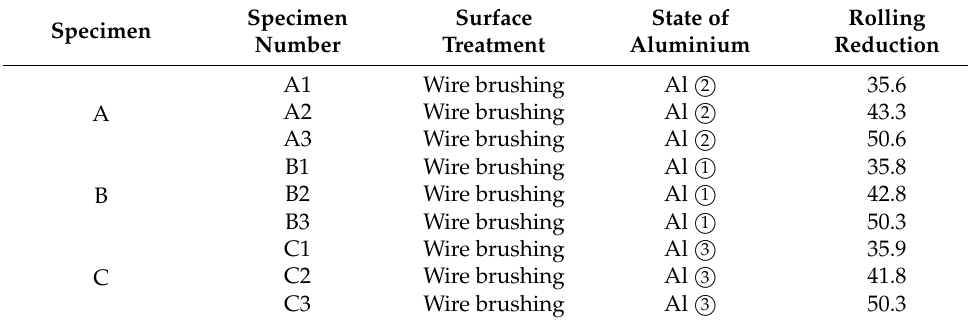
Table 3. Cold roll bonding process.